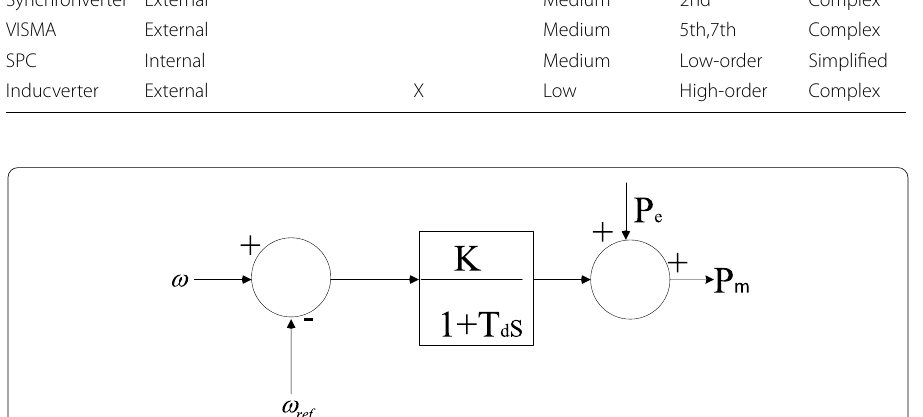
Fig. 6 Transfer function block diagram of swing equation based synchronous power controller